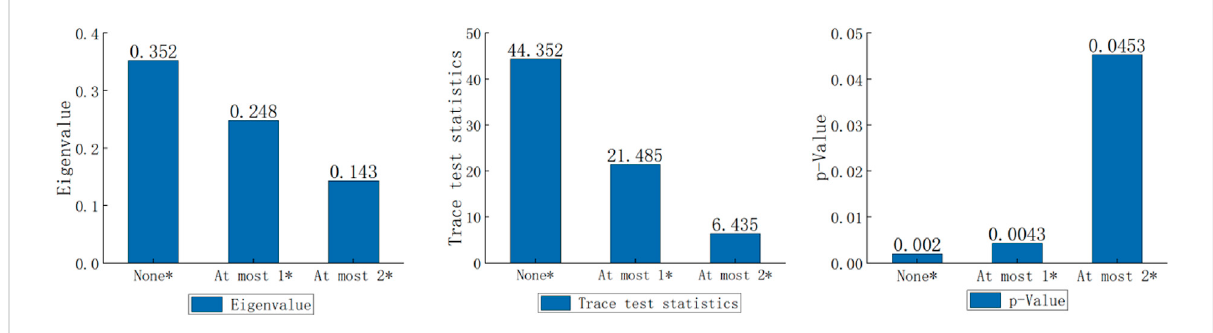
FIGURE 4 Johansen cointegration test